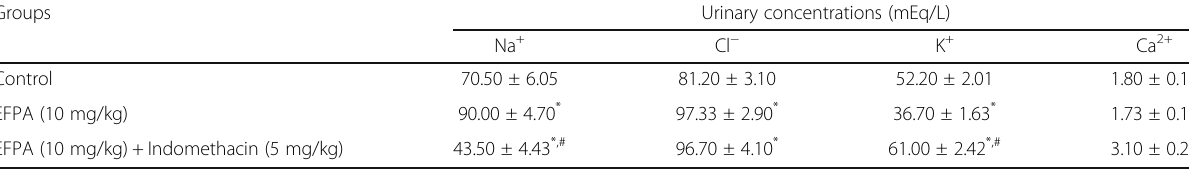
Table 2 Inhibitory effect of indomethacin on urinary electrolyte excretion induced by EFPA in rats Groups